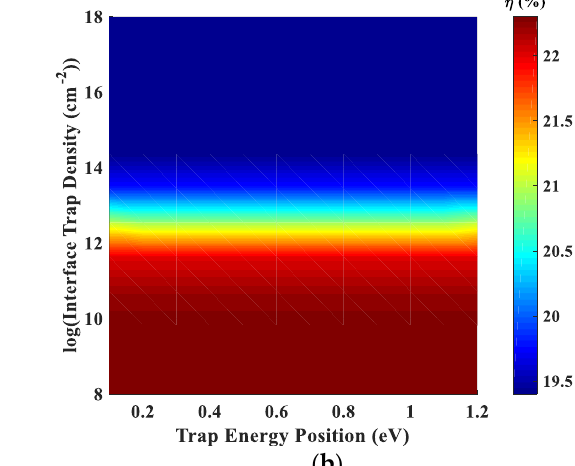
Figure 19. A comparison between ( a ) the illuminated J – V characteristics and ( b ) quantum efficiency